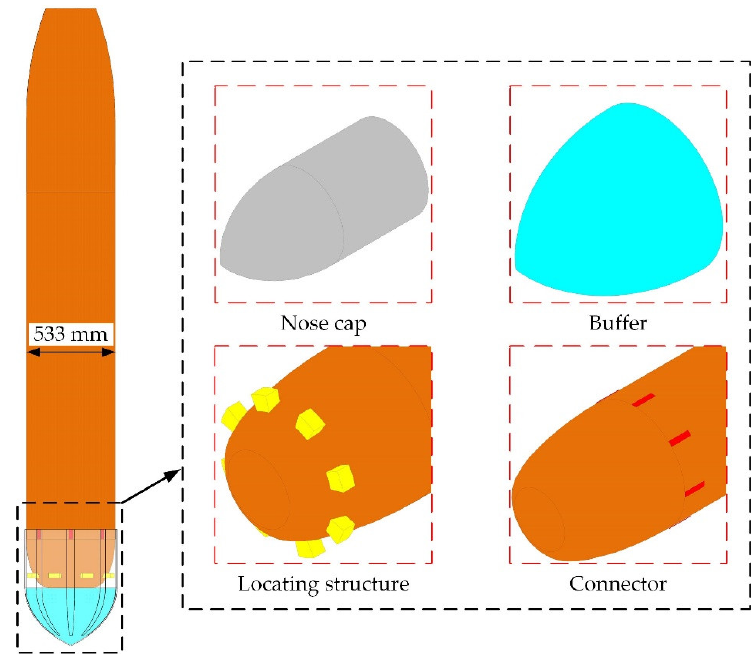
Figure 1. Schematic diagram of the head cap.